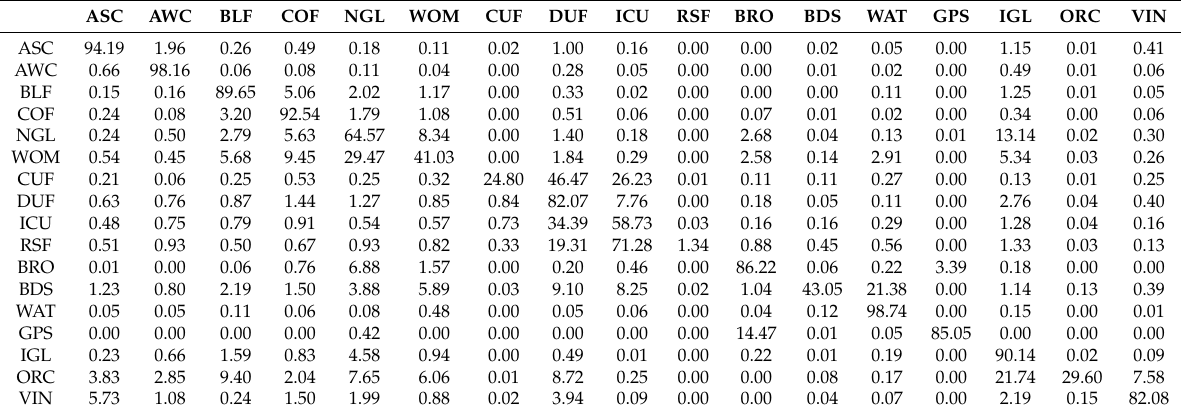
Table 3. Confusion matrix for the eco-climatic stratification approach. Columns represent produced labels and rows represent the reference labels. Values are given in percentage of reference pixels (normalised per row). Diagonal values represnent the recall for each